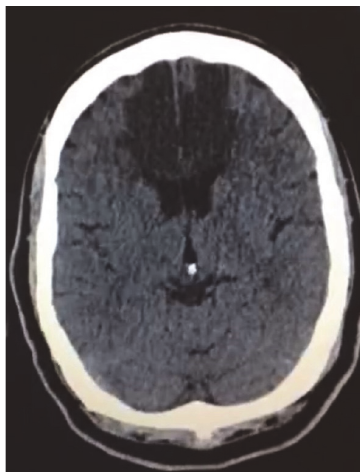
Figure 1: Cerebral computerized tomography scan, axial view, showing image of ischemic cerebral stroke in typical irrigation territory of the bilateral anterior cerebral artery.